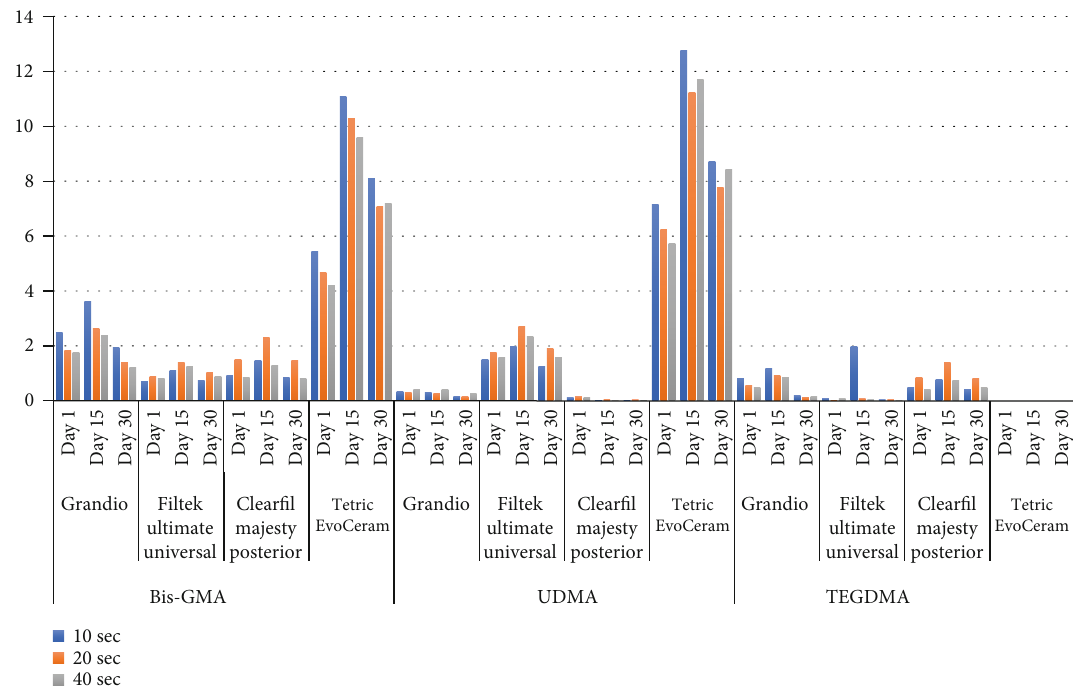
Figure 3: The amount of eluted (organic wt%) Bis-GMA, UDMA, and TEGDMA from di ff erent composites, at di ff erent days and polymerization times. ∗∗ Unit of all released monomers ’ volume is in ppm. 1 ppm = 0 : 001mg/mL